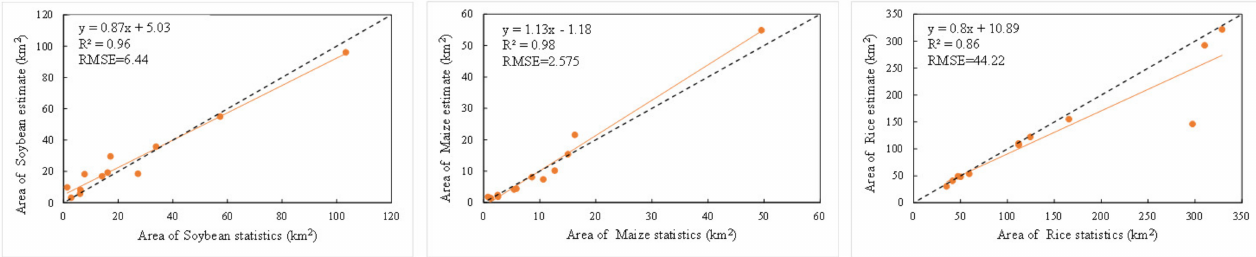
Figure 12. Correlation of the model − estimated main crop area with the statistical area in 2020.